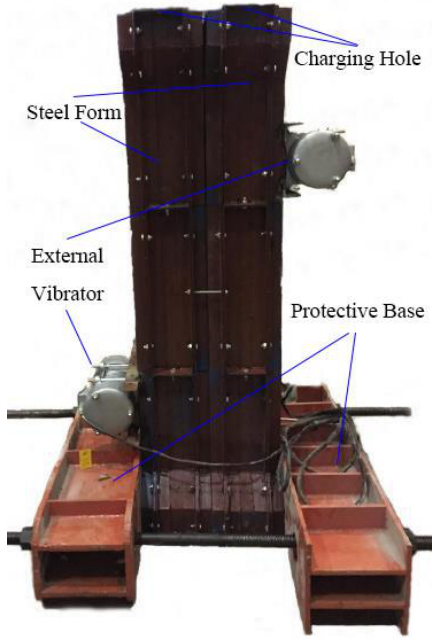
Figure 5. The pouring method and the equipment.